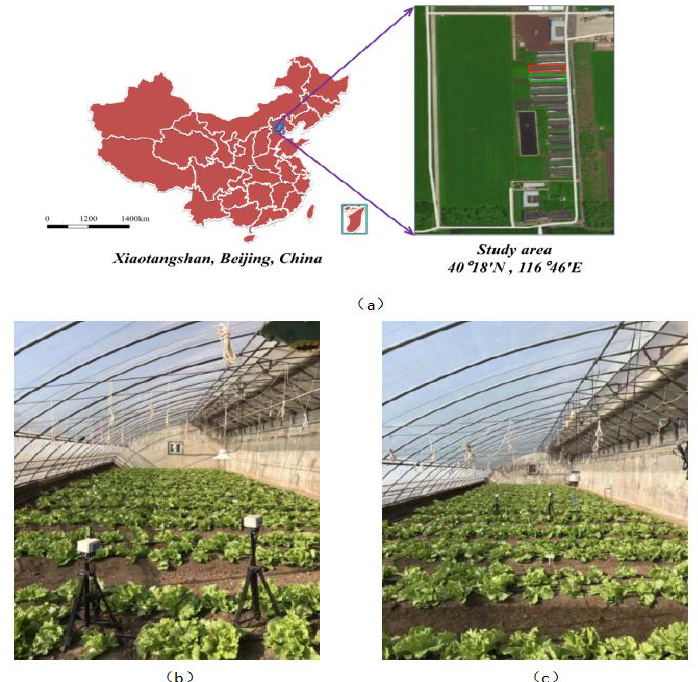
Figure 1. Experimental site and layout of the two seasons. ( a ) Location of the study area for the two-season experiment. The green box indicates the light conversion film greenhouse, and the red box indicates the ordinary film greenhouse. Photographs of the light conversion film greenhouse and ordinary film greenhouse are shown in ( b , c ), respectively.